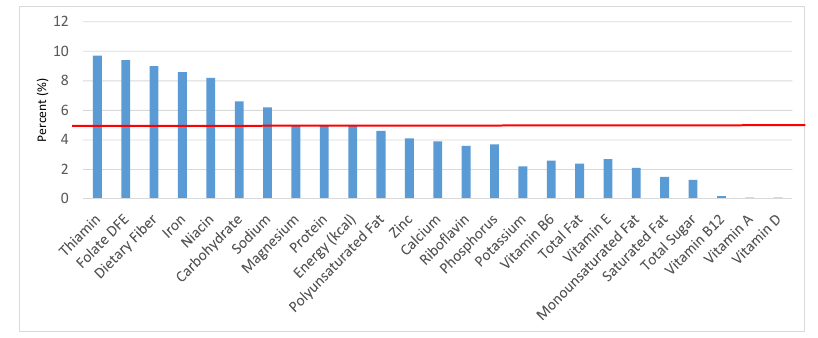
Figure 6. Breads, Rolls and tortilla as sources of energy and nutrients for children and adolescents 2–18 years old ( N = 6109, daily intake data): DFE = Dietary Folate Equivalents; solid red line represents percentage of energy (kcal) provided in the diet relative to nutrients—nutrients above the red line show the grain food’s contribution to nutrient density.